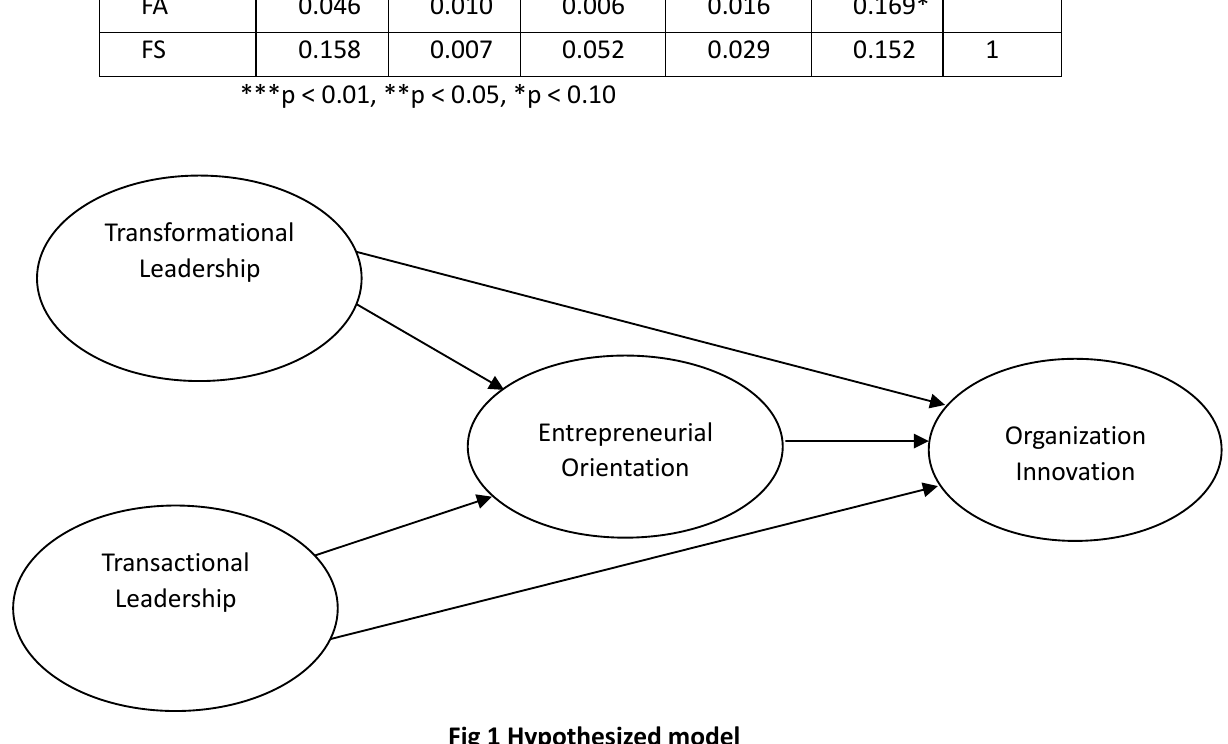
Fig 1 Hypothesized